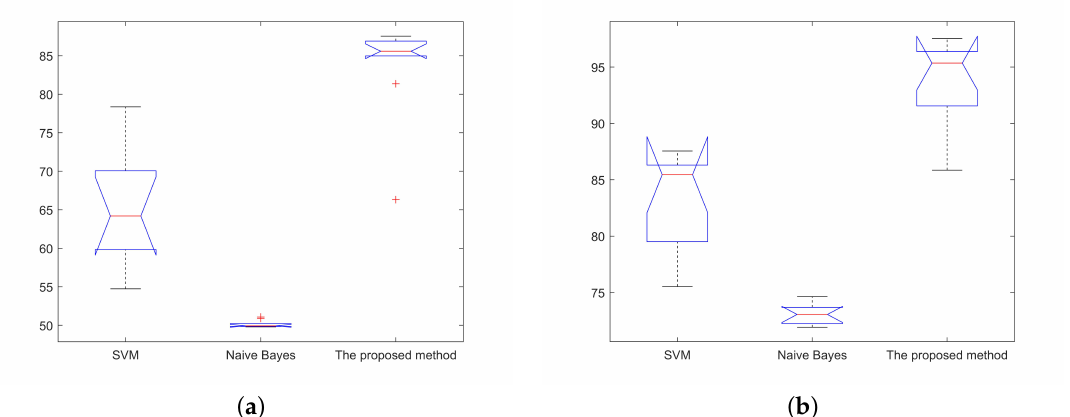
Figure 11. Statistical significance test of Accuracy for different models. ( a ) English dataset (F-statistics is 91.20). ( b ) Chinese dataset (F-statistics is